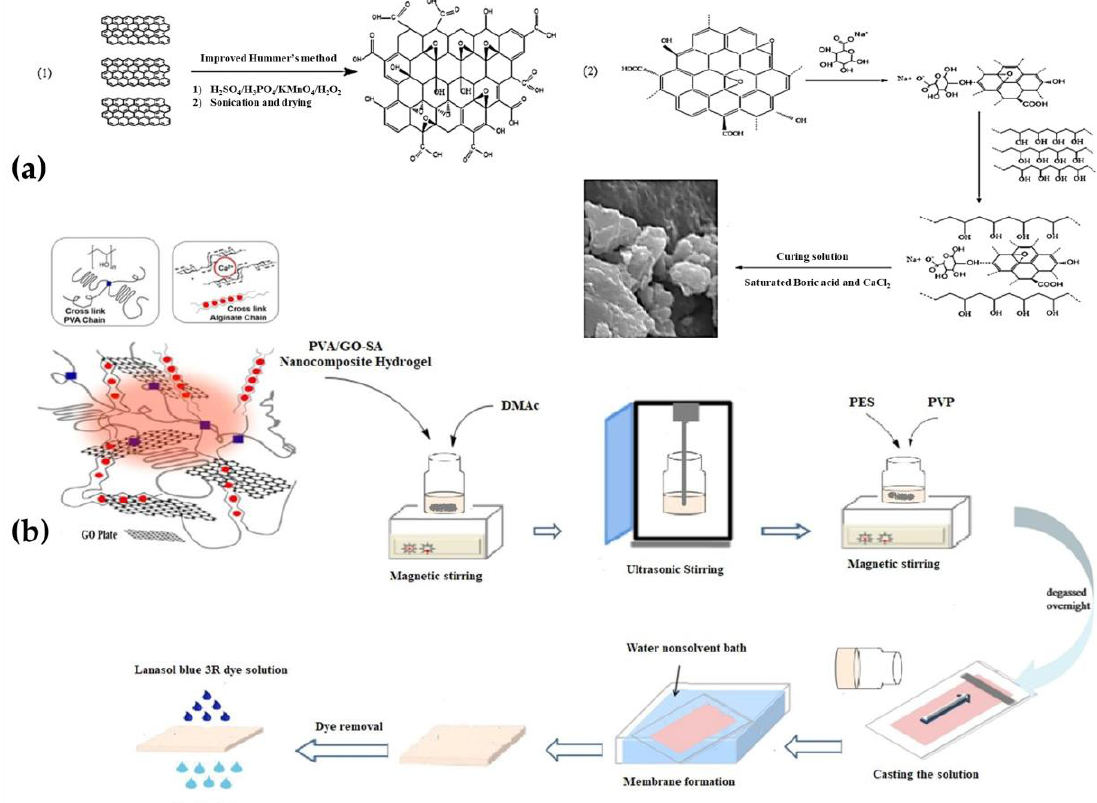
Figure 5. PVA-GO-NaAlg nanocomposite hydrogel production steps ( a ); description of the prepa- ration of the functional bio-polymeric blend and final membrane ( b ). Reproduced with permission from Separation and Purification Technology; published by Elsevier, 2020 [83].